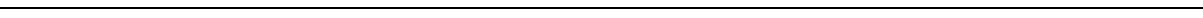
Fig. 5 TGF- β neutralizing antibody attenuates HO induced by BMP-2/gelatin implantation and FOP mice. a – c Mice were treated with 5 mg/kg body weight of the TGF- β neutralizing antibody 1D11 three times a week for 2 weeks from 1 day (D1), 2 weeks (W2), and 4 weeks (W4) after BGI and analyzed 8 weeks after BGI or sham surgery. a micro CT images and b quantitative analysis of bone volume of heterotopic bone in hamstring muscles of mice. Scar bar, 4 mm. c H&E staining of ectopic bone in hamstring muscles. Scale bar, 100 μ m. d – k Mice were treated with 5 mg/kg body weight of 1D11 three times a week for 2 weeks from 1 day (D1) and 2 weeks (W2) after BGI and analyzed 4 weeks after BGI or sham surgery. d Immunostaining and e quanti fi cation of pSmad2/3 + cells in ectopic bone marrow. Scale bar, 50 μ m. f Nestin + (red) cells in the ectopic bone marrow and g quanti fi cation. Scale bar, 50 μ m. Blue indicates DAPI staining of nuclei. h CD31 + (red) and Emcn + (green) cells in the ectopic bone marrow and i quanti fi cation of the fold change of type H vessels normalized to that of Sham mice. Scale bar, 100 μ m. Yellow indicates type H vessels. j Immunostaining and k quanti fi cation of Ocn + cells of in ectopic bone marrow. Scale bar, 50 μ m. l , m Ad.Cre and cobra venom factor-injected caALK2 transgenic mice were treated with vehicle or 1D11 three times a week for 3 weeks. l Micro CT images of hamstring muscles after vehicle or 1D11 treatment and m quantitative analysis of bone volume. Scale bar, 4 mm. All data are shown as the mean ± s.d. n = 8 per group. b , e , g , i , k * p < 0.05 as determined by one-way ANOVA. m * p < 0.05 as determined by